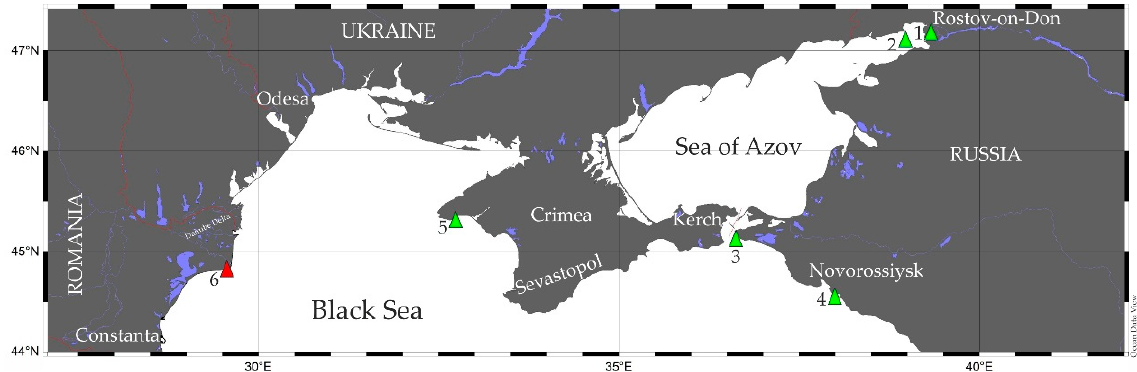
Figure 3. Known records of M. neglecta in the Azov and Black Seas. 1–2—Syomin et al., 2016